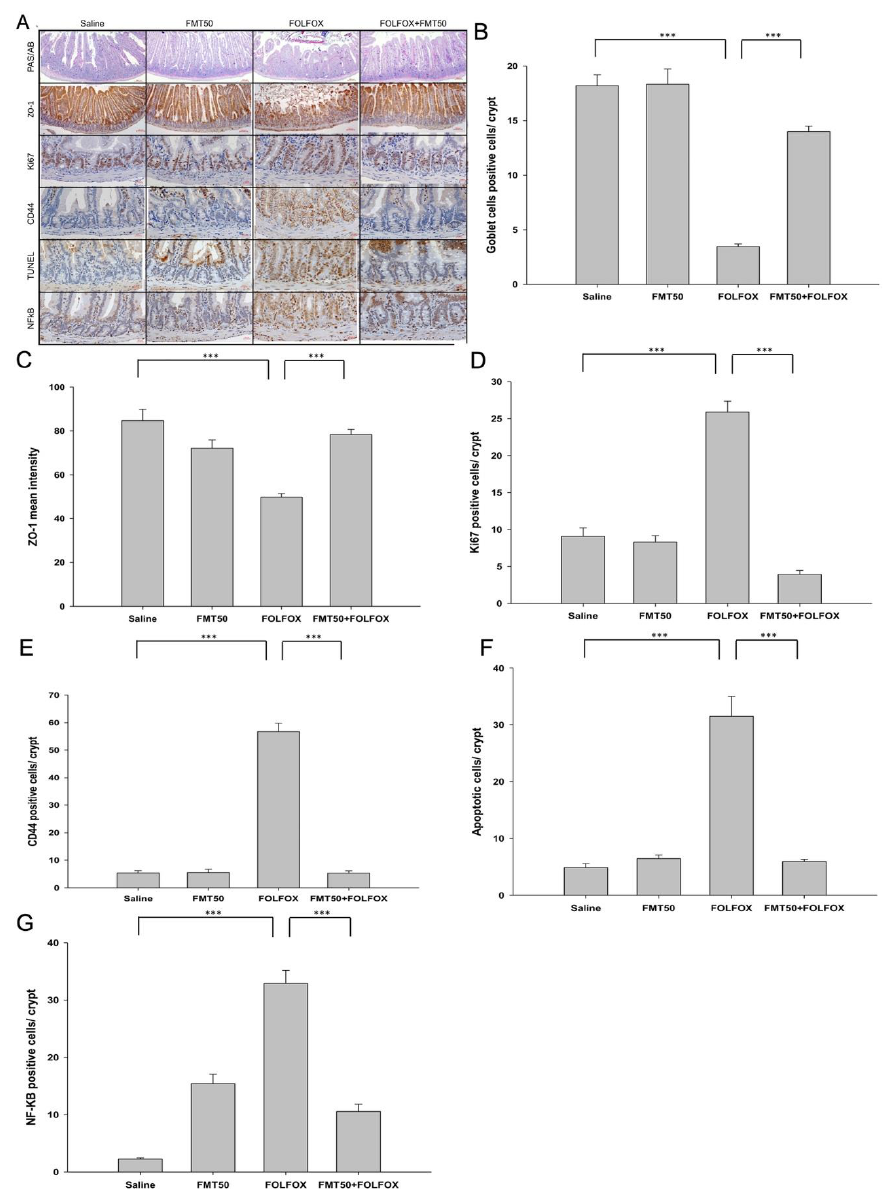
Figure 3. Activity of goblet cells, tight junctions, proliferation, regeneration, apoptosis, and NF-κB activity in subcutaneously injected mice with colorectal carcinoma presenting FOLFOX-induced intestinal damage with/without FMT ( n = 6 for each group). ( A ) Immunohistochemical staining of jejunum sections was used to determine the effects of FMT on periodic acid–schiff (PAS) dark purple)/alcian blue ( A , B ) staining (goblet cells); zonula occludens-1 (ZO-1) (brown) to detect tight junction integrity; Ki67 (brown) expression to detect proliferative activity; CD44 (brown) staining to detect regeneration activity; terminal deoxynucleotidyl transferase dUTP nick-end labeling (TUNEL) (brown) to detect DNA breaks; and NF-κB activity (brown) in the intestine using antibodies. We quantified the staining intensity of ( B ) PAS / AB and ( C ) ZO-1 in the intestinal villus, ( D ) Ki67, ( E ) CD44, ( F ) TUNEL, and ( G ) NF- κ B in the intestinal crypt in ( A ). Scale bar = 100 µ m. FMT50: 50 mg / mL. Values are presented as the mean ± SEM. ***: p <